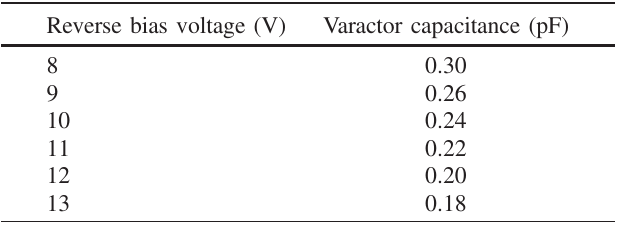
TABLE V. Varactor (MAVR-000120-1411) capacitance at each bias voltage, extracted from